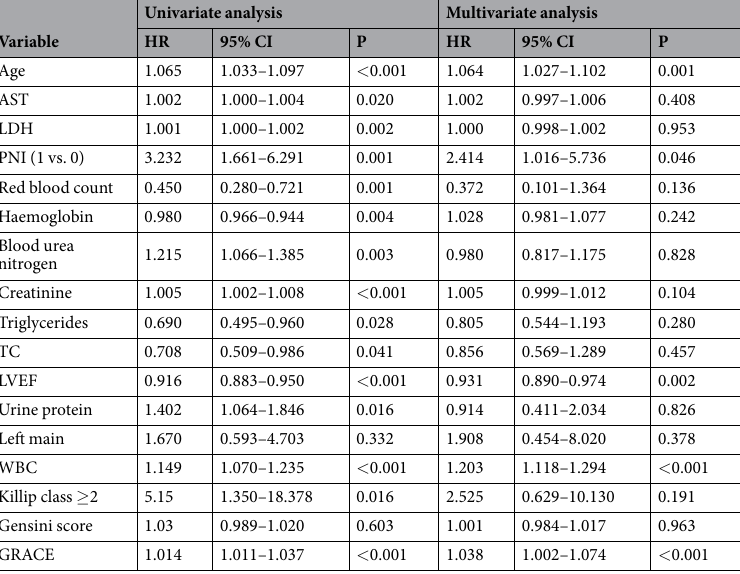
Table 3. Independent predictors of mortality in the Cox proportional hazard model. AST, aspartate transaminase; LDH, lactate dehydrogenase; TC, total cholesterol; LVEF, left ventricular ejection fraction; WBC,